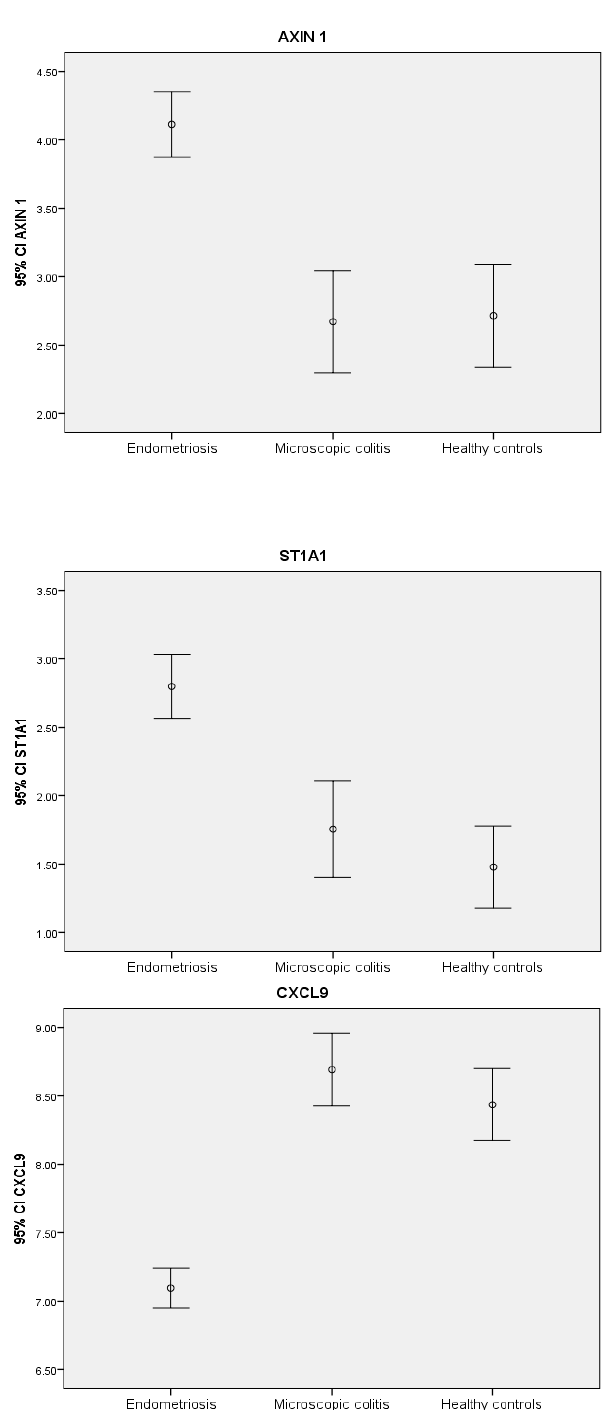
Figure 1. NPX levels in endometriosis and controls. NPX = normalized protein expression. The NPX unit is an arbitrary unit of concentrations. Figures indicate mean NPX value and 95% confidence interval of the mean value in each group; endometriosis ( N = 94), microscopic colitis ( N = 47) and healthy controls ( N = 28).